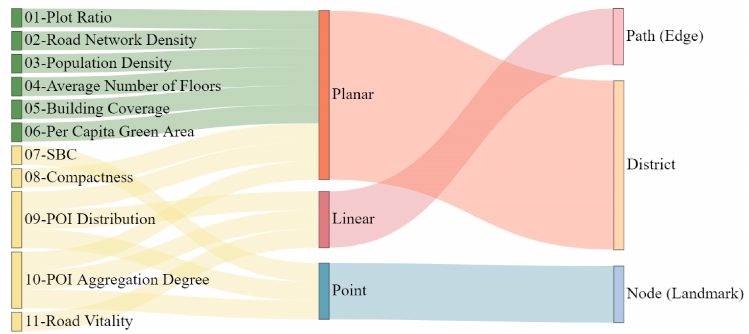
Figure 2. Image structure at the community